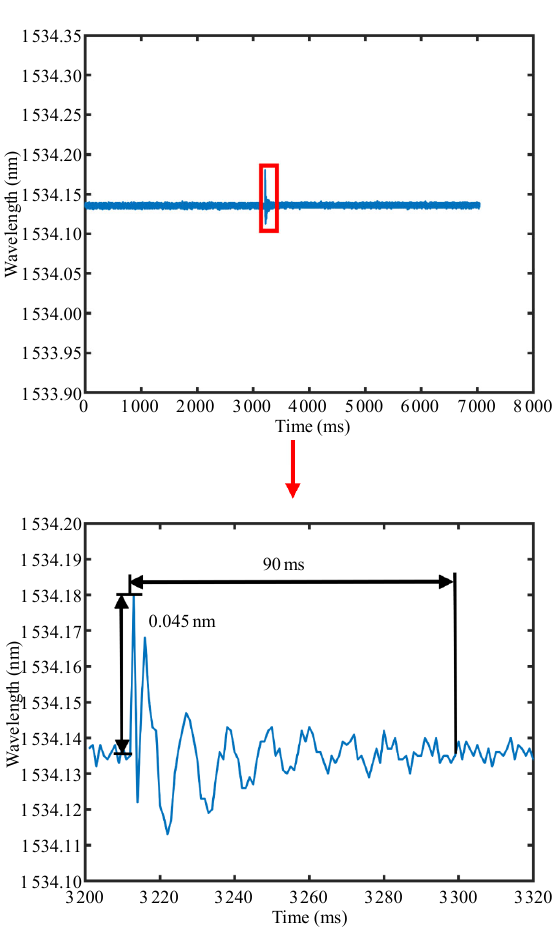
Fig. 13 Time-history curve of the wavelength with silicone oil.